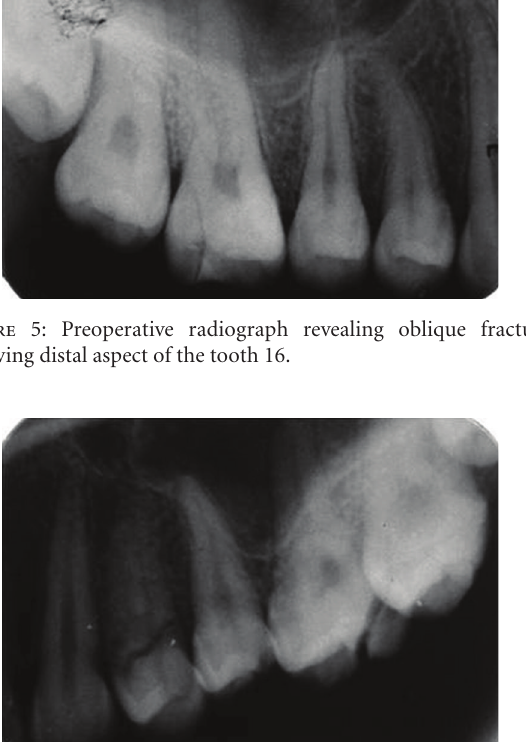
Figure 2: Oblique fracture of distofacial cusp with 26, loss of buccal cusp with 25.